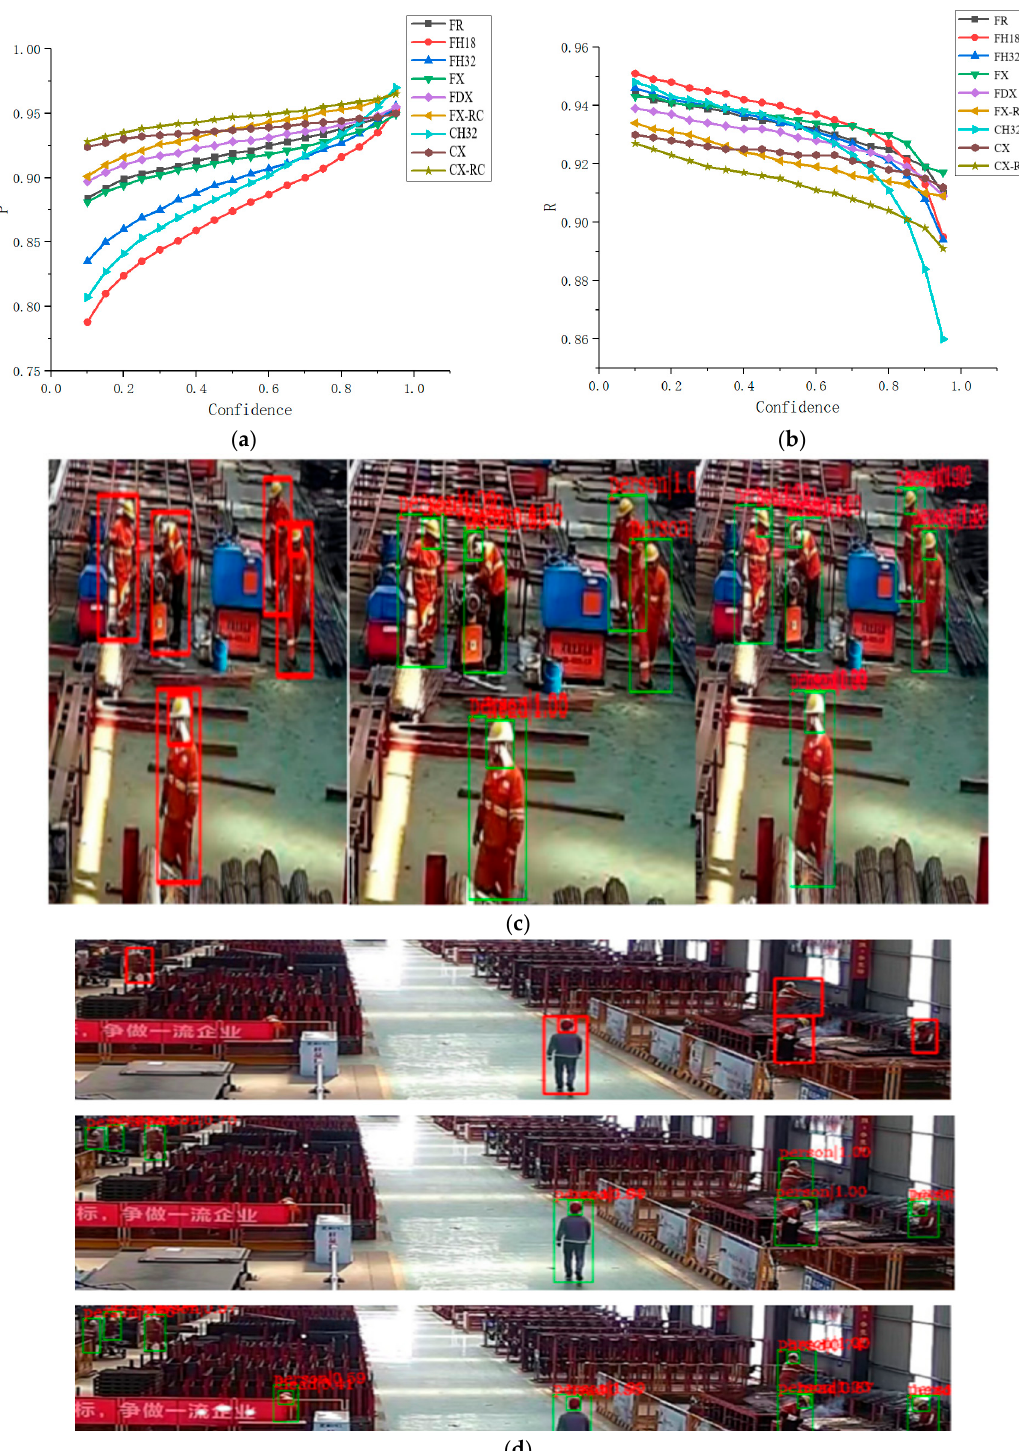
Figure 7. ( a ) Detection accuracy of the nine schemes obtained using the faster and cascade structures; ( b ) recall figures of the nine schemes; ( c , d ) detection results of two typical scenes.